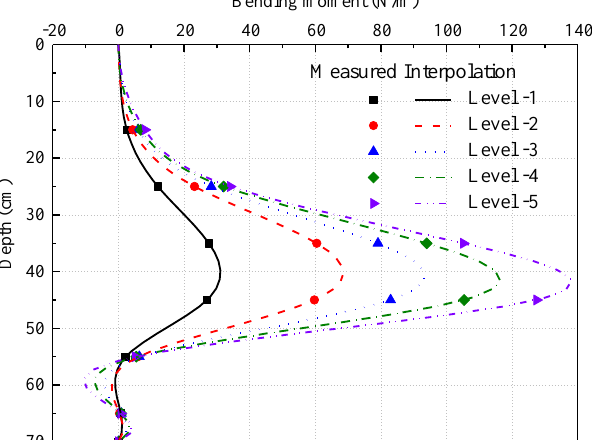
Appl. Sci. 2020 , 10 , x FOR PEER REVIEW Figure 10. Bending moment diagram for the stabilizing pile. Figure 10. Bending moment diagram for the stabilizing pile.